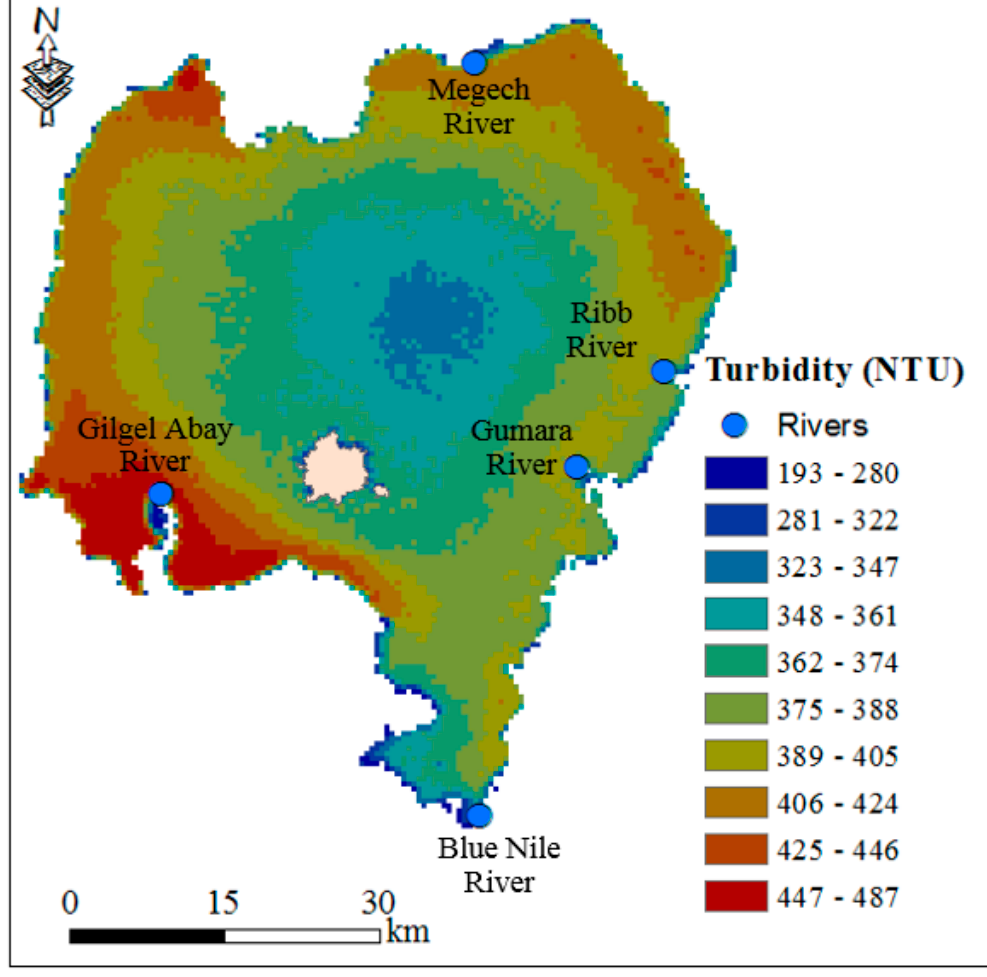
Figure 11. Long-term annual average turbidity of Lake Tana (2010–2016).